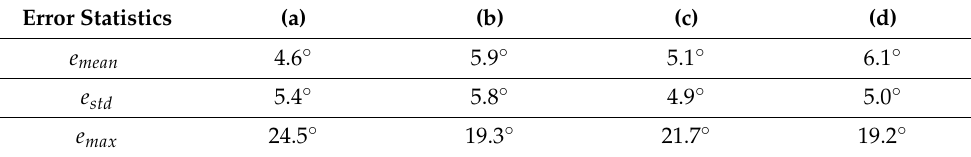
Table 5. Statistics for the error between the measured and desired trajectories. Error Statistics